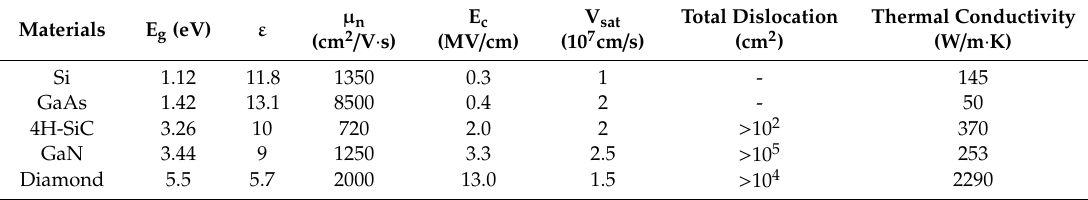
Table 1. Physical properties of Si, GaAs, SiC, GaN, and